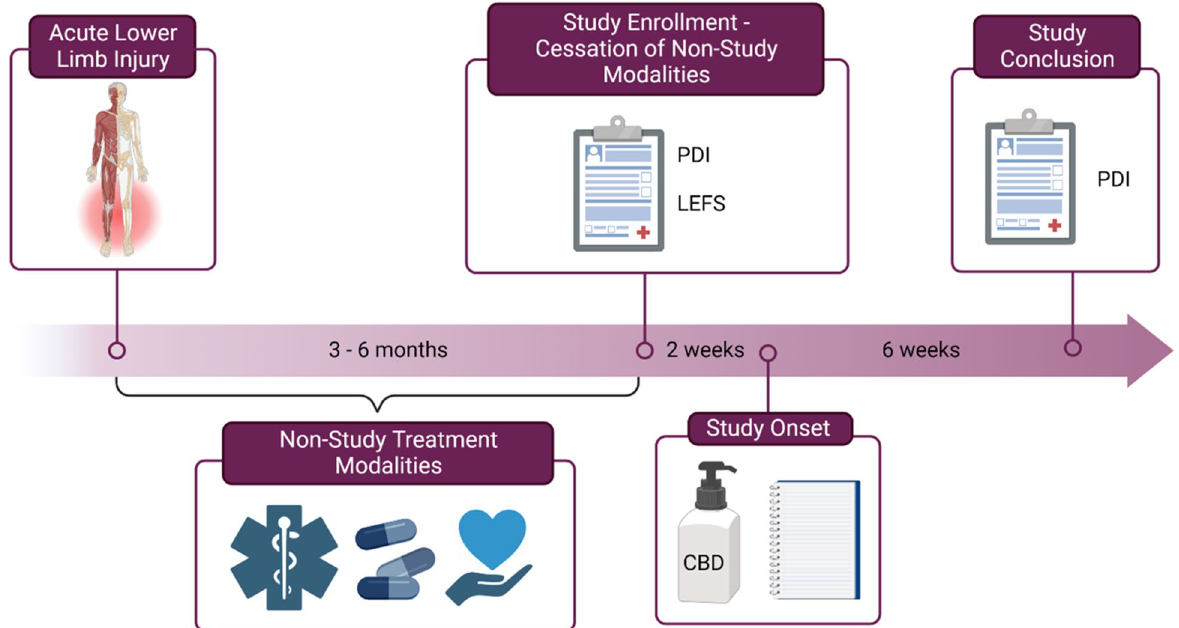
Fig. 1 Timeline of the study design. The participants reported experiencing a lower extremity injury 3–6 months prior to enrollment. They then underwent various non-study related therapeutic modalities, which they self-reported to be ineffective. At study enrollment, they were asked to discontinue all of these modalities during the study period. At intake, participants completed the Pain Disability Index (PDI) and the Lower Extremity Functional Scale (LEFS). They also began to complete a daily pain journal. Participants received cannabidiol (CBD) treatment at 10 mg twice daily by controlled topical dispenser for six weeks. At the conclusion of the study, they completed their last entry in the pain journal as well as a second